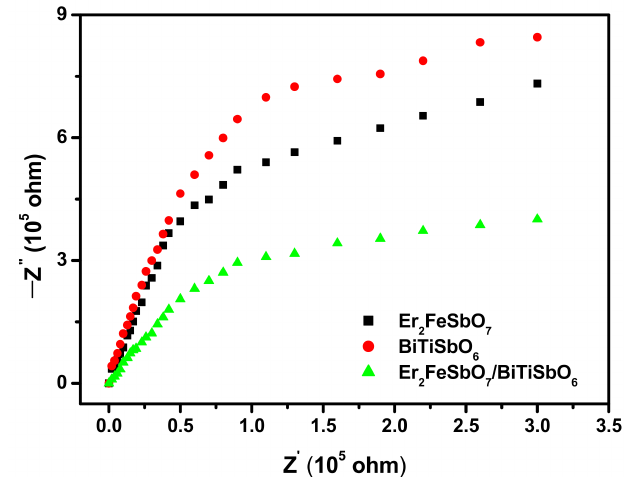
Figure 18. Nyquist impedance plots of EBHP, Er 2 FeSbO 7 or BiTiSbO 6